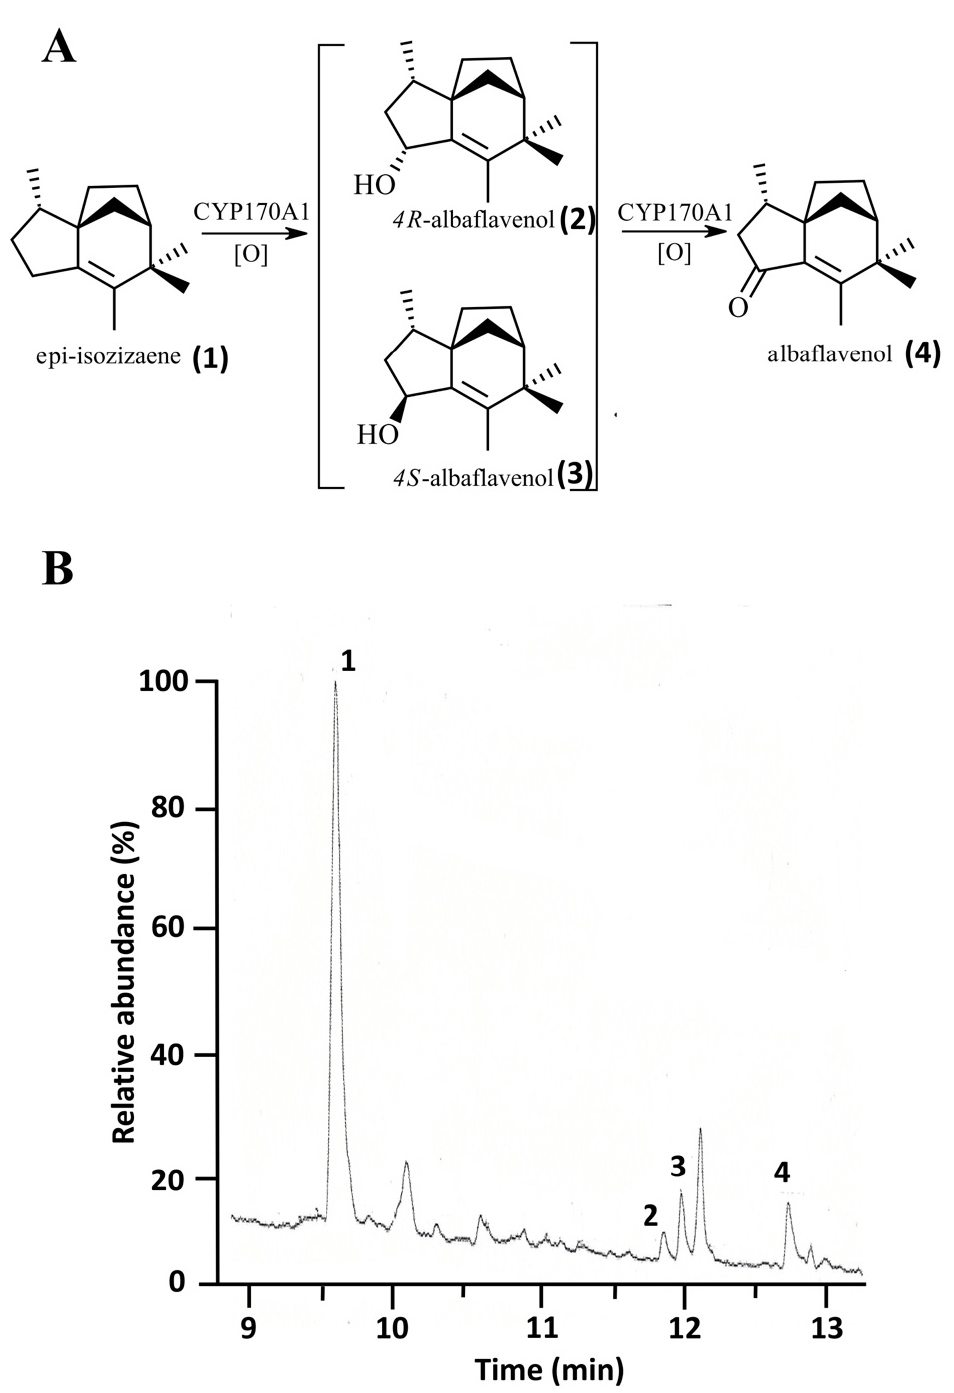
Figure 5. Epi-isozizaene allylic oxidation by CYP170A1 supported by 0305 ϕ 8-36 flavodoxin. ( A ) Metabolic pathway for the formation of albaflavenone catalysed by CYP170A1. ( B ) In vitro catalytic activity of CYP170A1 supported by 0305 ϕ 8-36 and E. coli flavodoxin reductase. Product profile was obtained using individual component concentrations as follows: 1 nmol CYP170A1, 10 nmol 0305 ϕ 8-36 flavodoxin or 10 nmol E. coli flavodoxin, 2.0 nmol E. coli flavodoxin reductase